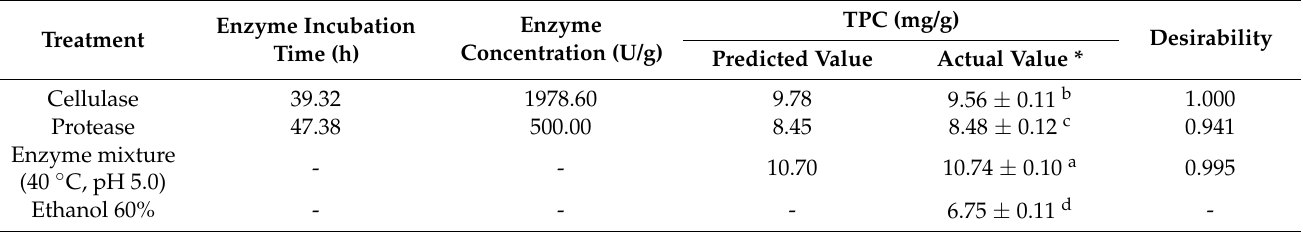
Figure 1. The response surface plots and perturbation plots of the effects of incubation time, enzyme concentration, incubation temperature, and pH on the TPC values in corn tassel extract by cellulase ( a ), protease ( b ), and their mixture ( c ) assisted extraction. Table 1. Predicted and actual values of TPC in corn tassel extracts by cellulase-, protease-, and their mixture (1:1)-assisted extraction.